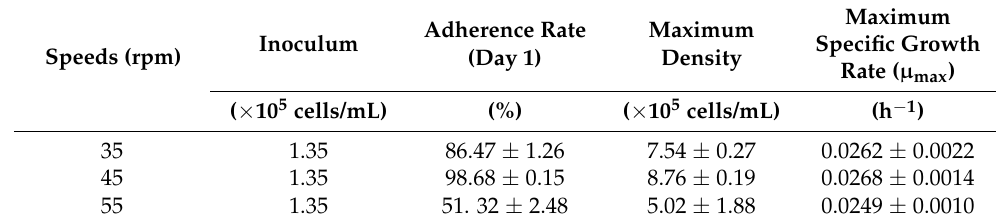
Table 1. Effects of agitation speeds on the proliferation of hUCMSCs cultured in 200 mL spinner flask.